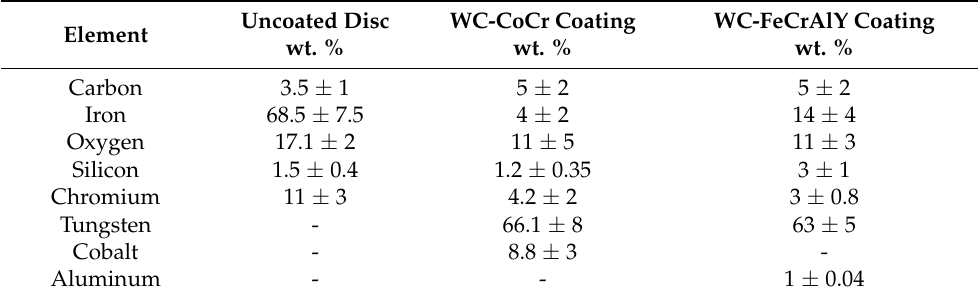
Table 9. Composition of the friction layer that was deposited onto the worn disc surface during the PoD